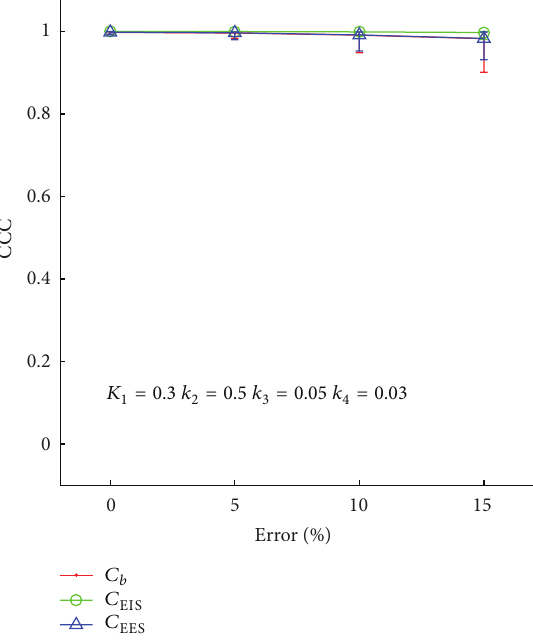
Figure 5: The concordance correlation coefficient between the estimated and true values for the time courses as a function of error in the DCE-MRI parameters for a single set of PET kinetic parameters. The method is able to return the time courses faithfully when the DCE-MRI parameter error is less than 5%. With higher error in the DCE-MRI parameters, the CCC remains above 0.95 on